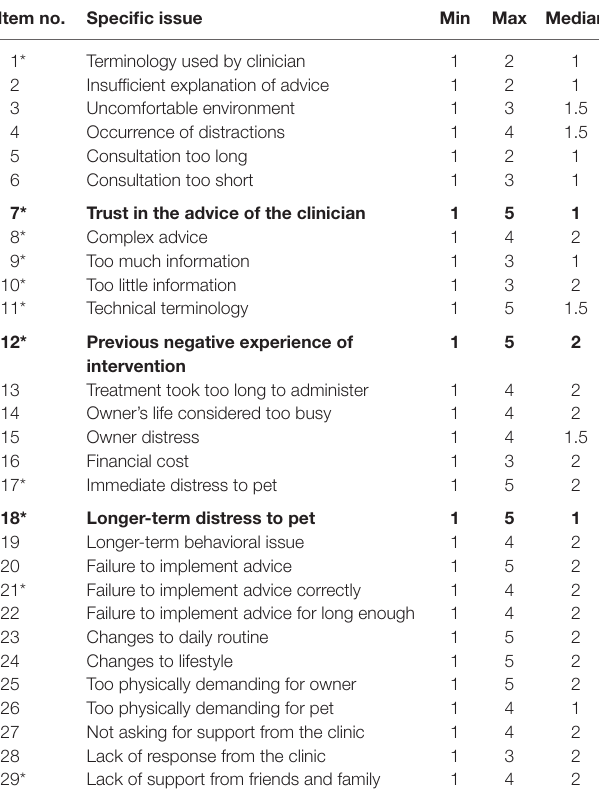
TaBle 3 | Summary of client ratings (minimum, maximum, and median scores) of specific issues associated with nonadherence from behavior consultation and their significance with respect to treatment